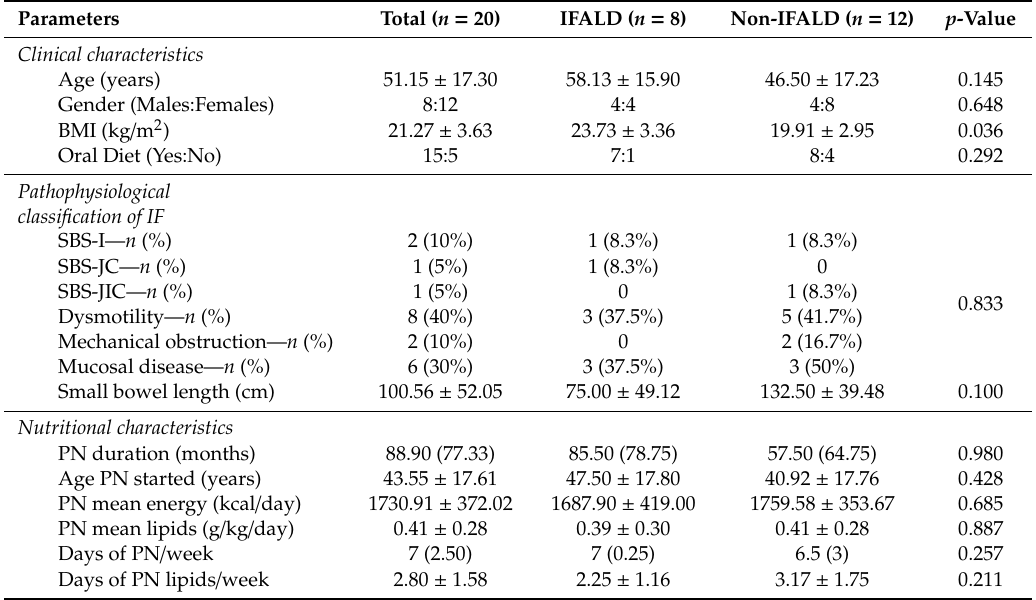
Table 2. Comparisons of clinical and nutritional characteristics between adult participants with IF diagnosed with IFALD or no IFALD by radiological examinations (mean ± SD and median